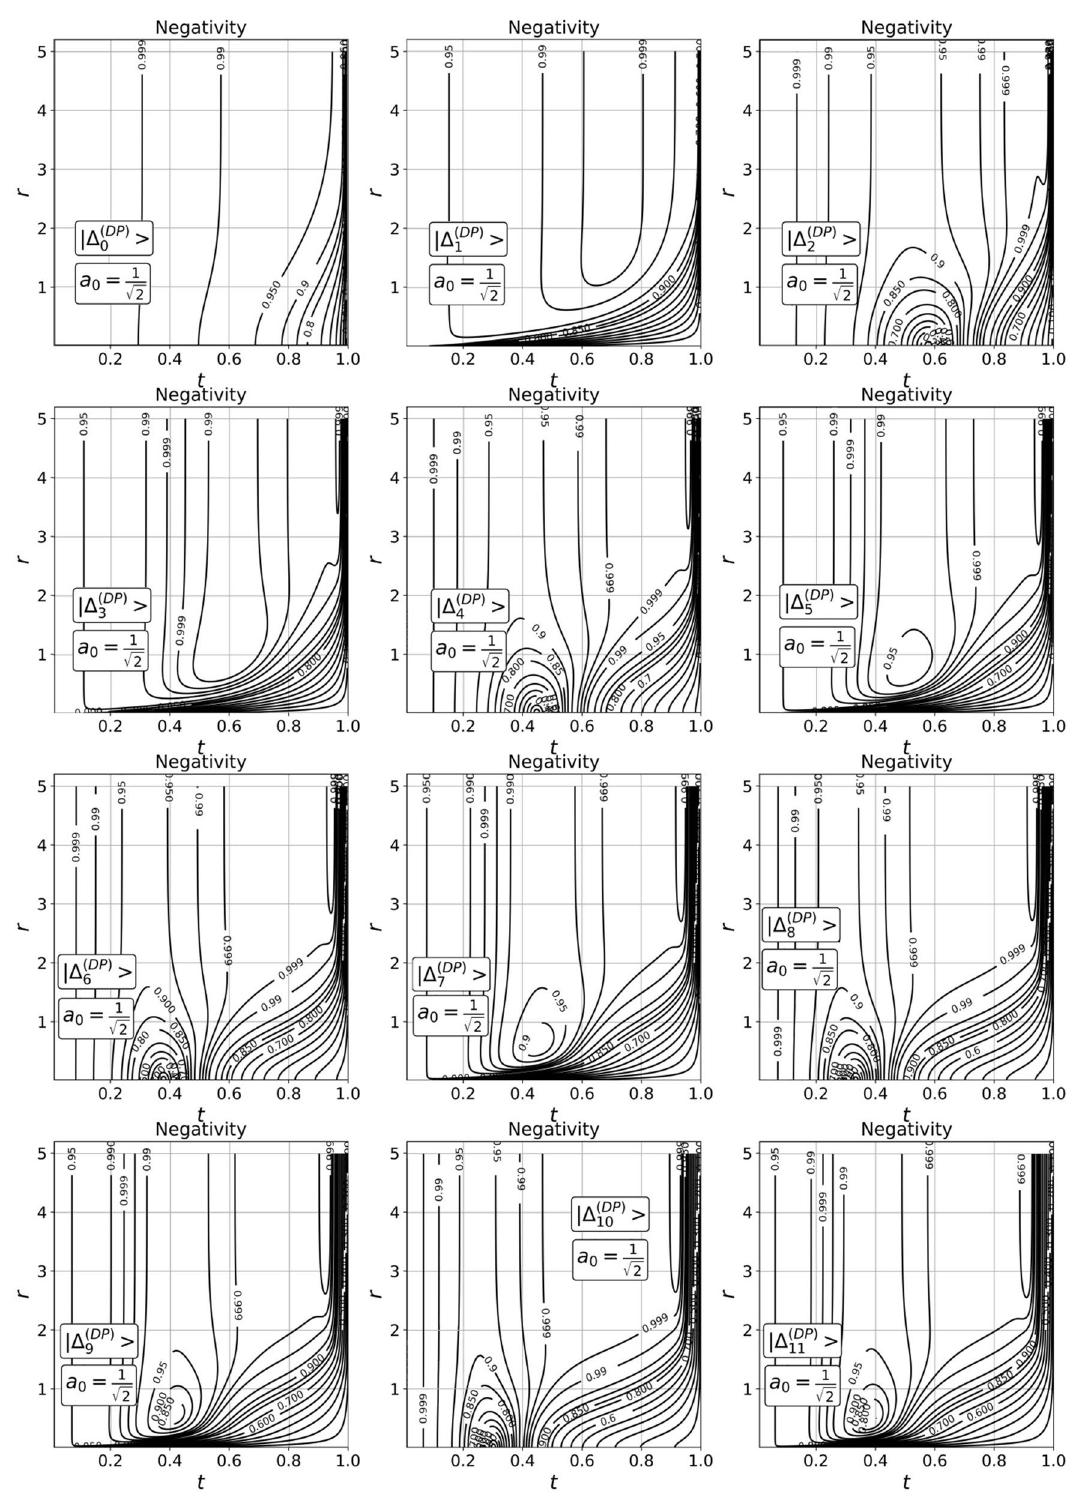
Figure 6. Contour lines of the negativity as a function of t and r for the conditional states in Eq. (17) with n varying from 0 up to 11 in the case of input balanced delocalized photon in Eq. (16) with a a 1 / √ 2 0 1 = =